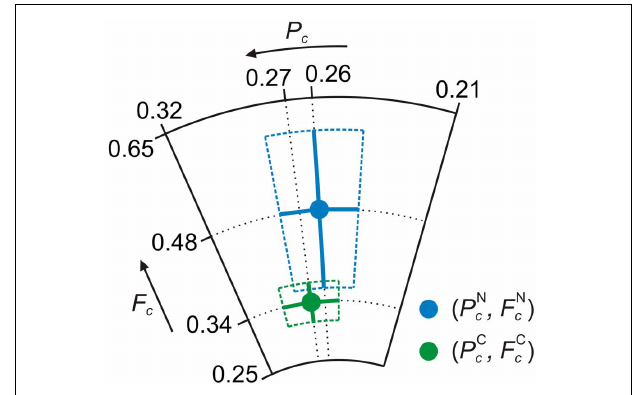
FIGURE 6 | Argand diagram of the NIXSW experimental results for AB/Ag(111). Green filled circle: Average experimental ( P c , F c ) = (0 . 27 ± 0 . 02, 0 . 34 ± 0 . 03) of carbon. Blue filled circle: Average experimental ( P c , F c ) = (0 . 26 ± 0 . 02, 0 . 48 ± 0 . 12) of nitrogen. Green and blue solid lines: Corresponding error bars. Green and blue dashed lines: Corresponding error regions